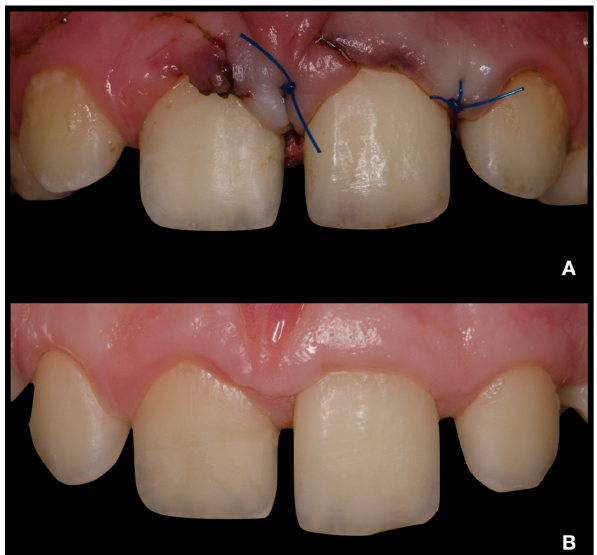
Figure 7. Intraoral photographs of teeth 12–22 from buccal view. ( A )—immediately after treatment; ( B )—24-month follow-up. ( B )—24-month